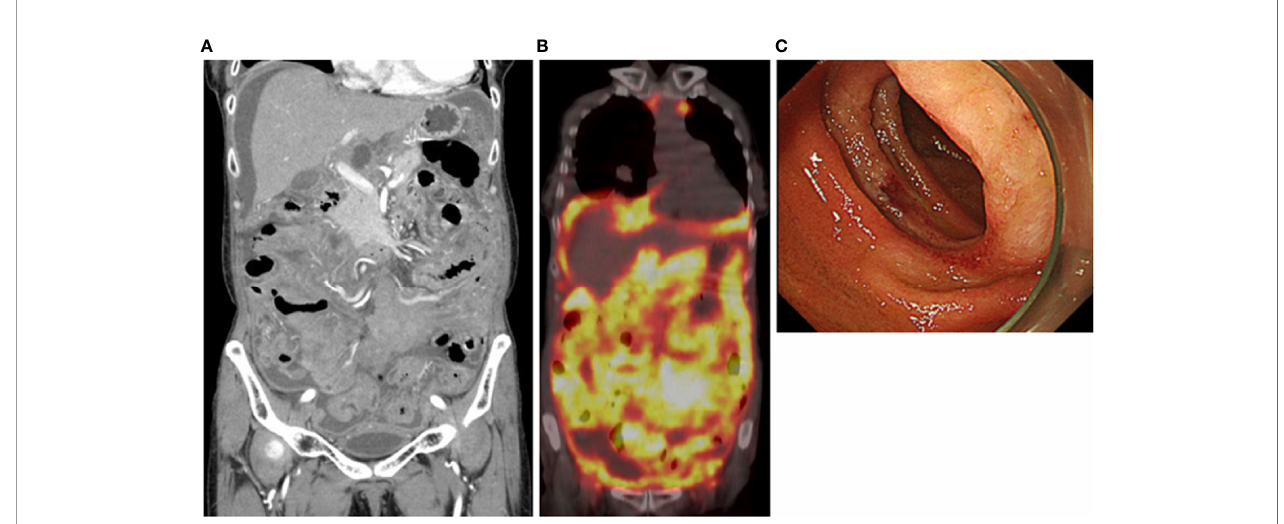
FIGURE 1 | Massive accumulation of 18F- fl uorodeoxyglucose into the abdominal cavity in positron emission tomography. (A) Moderate ascites and wall thickening of the jejunum and ileum were seen in contrast-enhanced computed tomography. (B) Massive accumulation of 18F- fl uorodeoxyglucose was observed into the peritoneum and small bowel wall. (C) An endoscopic image of a jejunum tumor detected by double balloon-assisted enteroscopy. A whitish elevated tumor was seen in the proximal